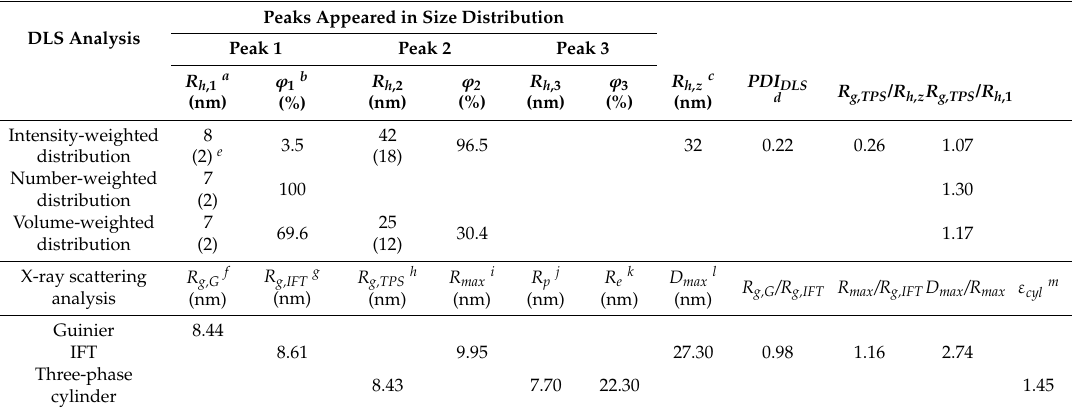
a Averaged hydrodynamic radius. b Fraction in percent. c z -Averaged hydrodynamic radius. d Polydispersity index in the DLS data analysis, which is defined by Equation (11). e Standard deviation. f Radius of gyration determined from Guinier analysis. g Radius of gyration determined from IFT analysis. h Radius of gyration determined from three phase cylinder (a three phase structure (TPS)) analysis. i Radius determined from the peak maximum of the p ( r ) function in IFT analysis. j Radius of cylindrical micelle. k Height of cylindrical micelle. l Maximum dimension determined from the p ( r ) function in IFT analysis. m Aspect ratio ( ε cyl = cylinder height/diameter).